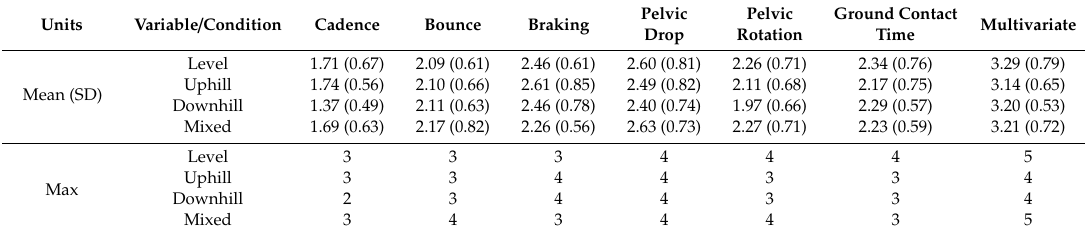
Table 3. Number of days (mean, standard deviation (SD) and maximum) needed to define a stable running pattern (univariate and multivariate).